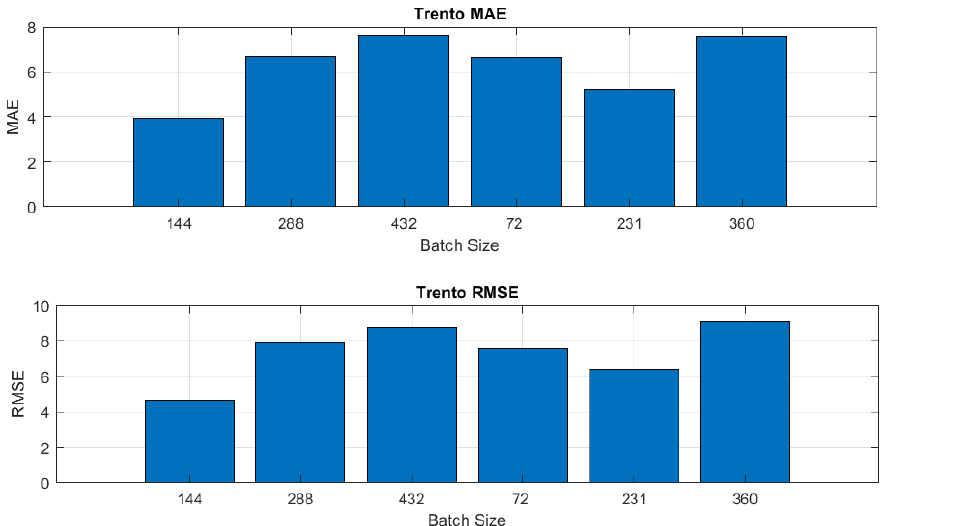
Figure 7. Metrics for Trento case: Trento MAE and Trento